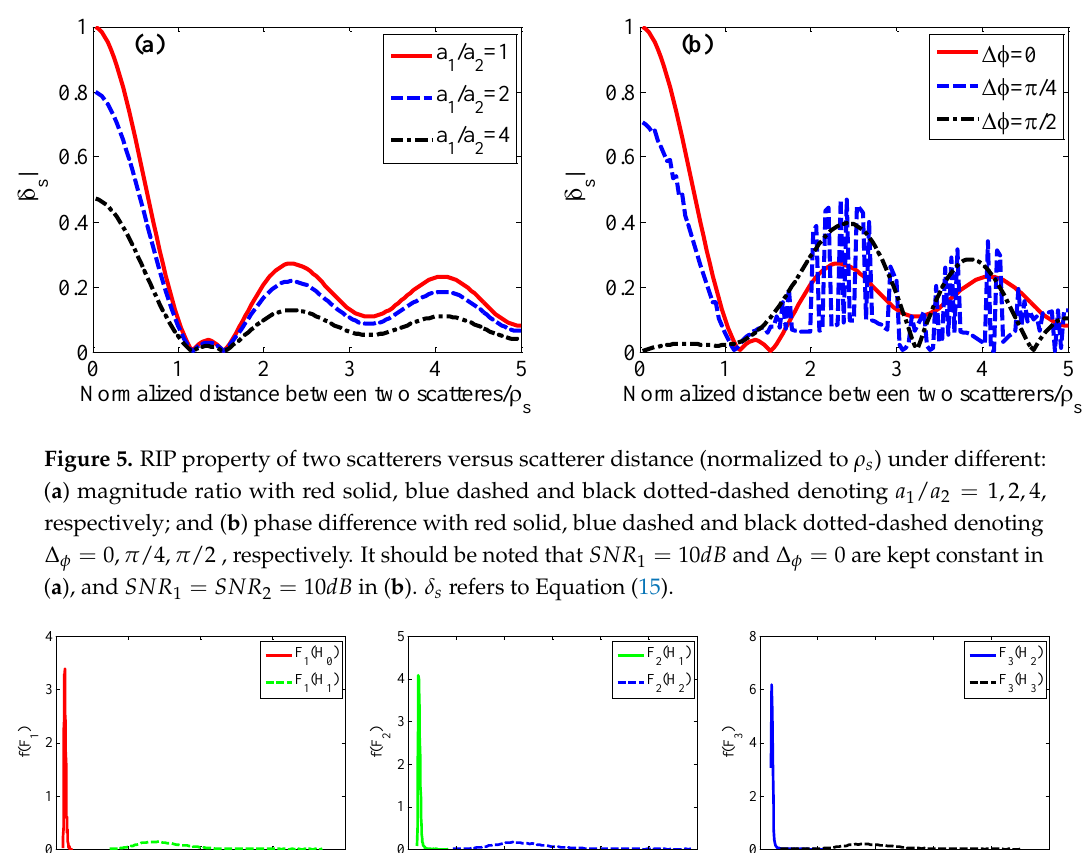
Figure 6. PDFs of F i under different hypotheses of H 0 (red), H 1 (green), H 2 (blue) and H 3 (black) with SNR=10dB and scatterers separation of ρ s for H 2 , and of ρ s and 1.5 ρ s for H 3 :( a – c ) the PDFs of F 1 , F 2 and F 3 ,